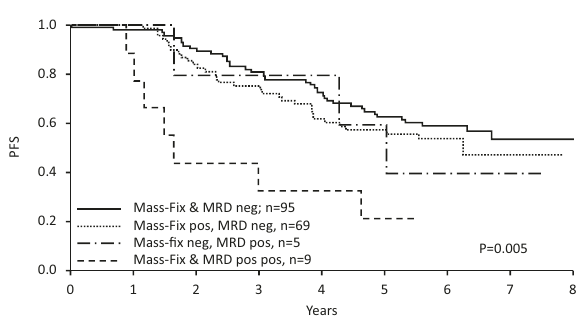
Fig. 3 Interaction between Mass-Fix and MRD status and PFS using 1-year post enrollment MRD and Mass-Fix results.